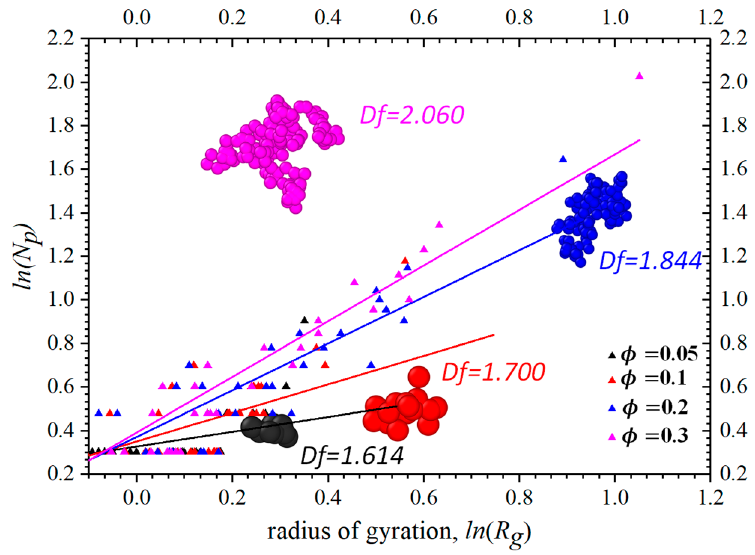
Figure 10. The fractal dimension and monomers number in the aggregates with different volume